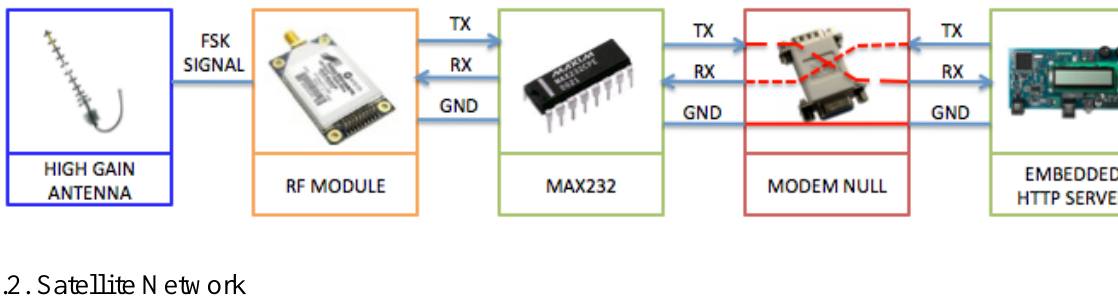
Figure 7. Connections between the Embedded HTTP Server and the RF